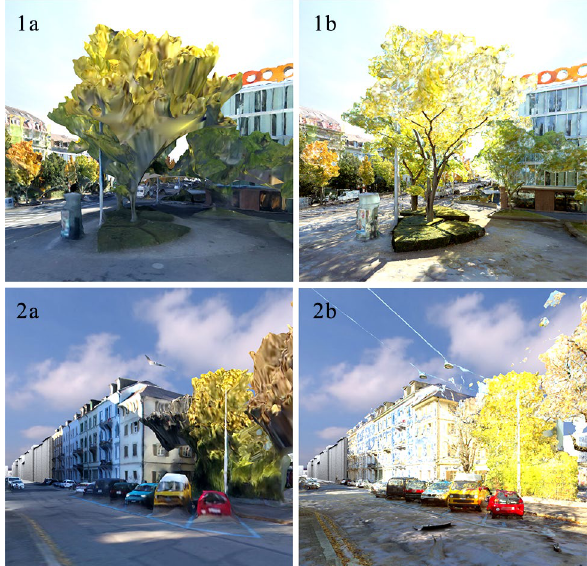
Figure 15. Illustrations of different textured 3D models of identical sub-scenes. Scenes 1a and 2a: UAV only, scenes 1b and 2b: fusion UAV and MMS (from street and sidewalks).